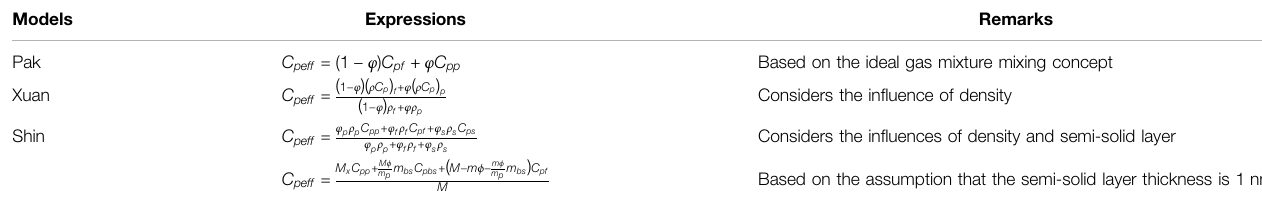
TABLE 4 | Speci fi c heat capacity calculation models for nano fl